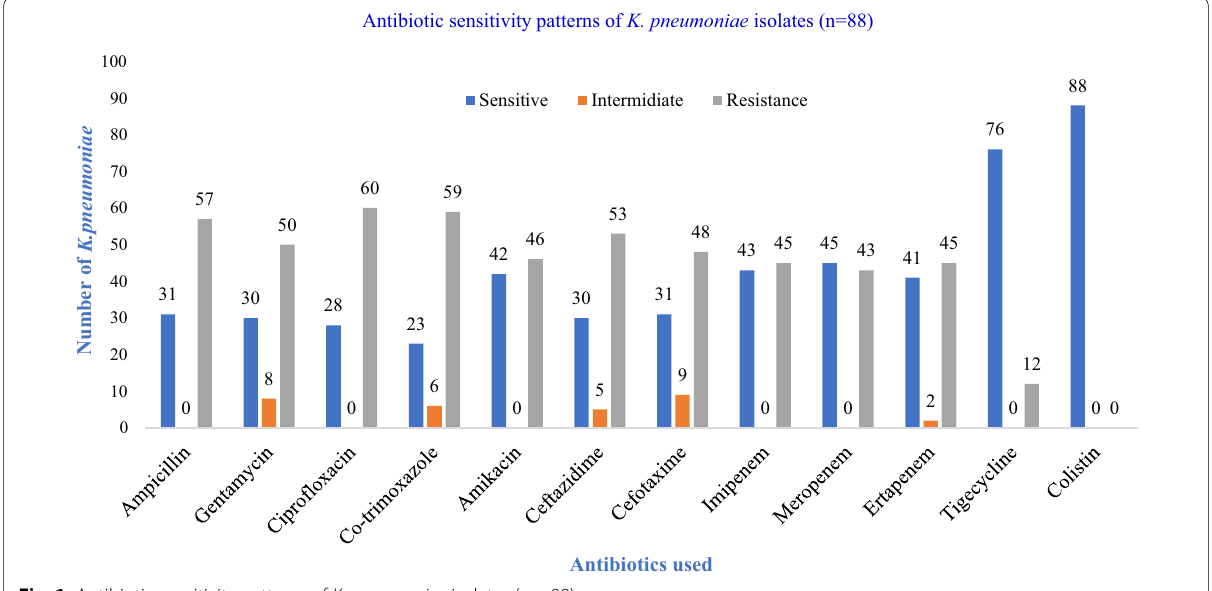
Fig. 1 Antibiotic sensitivity patterns of K. pneumoniae isolates ( n